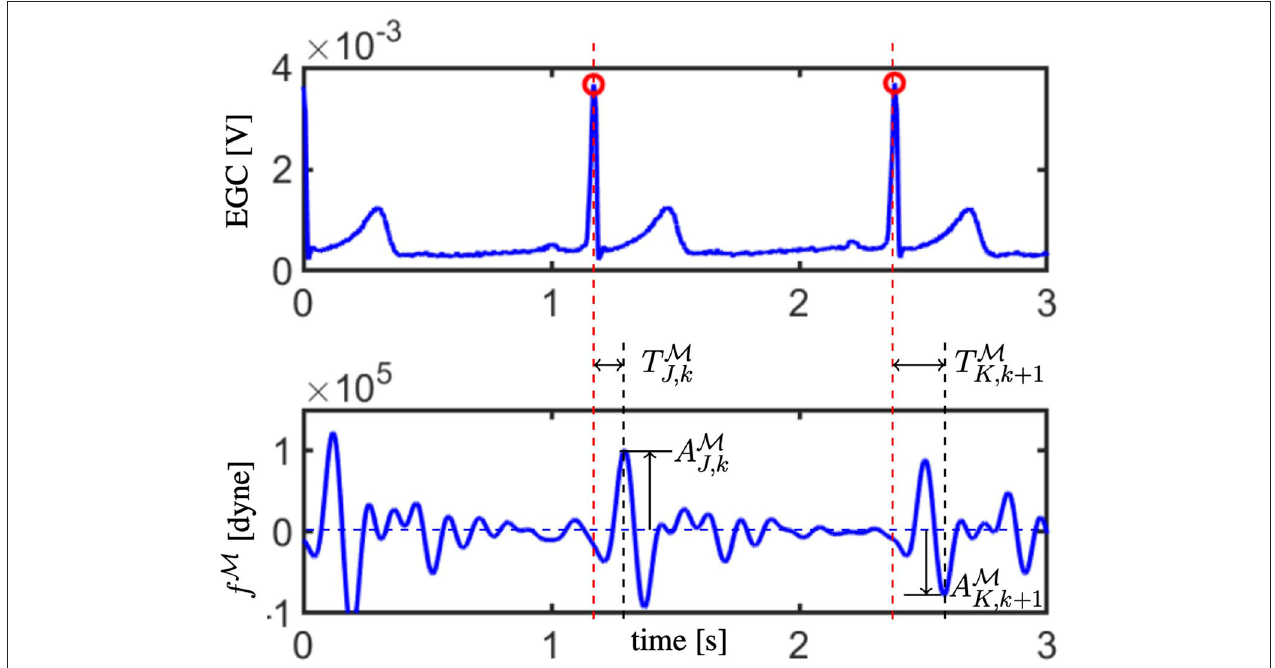
FIGURE 3 | The electrocardiogam (ECG; top) and f M waveform (bottom) acquired synchronously are reported. R peaks in the ECG are marked with red circles and their time location is indicated by red dashed vertical lines. Amplitude and timing for the J peak are reported for the k − th curve (refer to A M J , k and T M J , k ), whereas the amplitude and timing for the K valley are reported for the following ( k + 1) − th curve (refer to A M K , k + 1 and T M K , k + 1